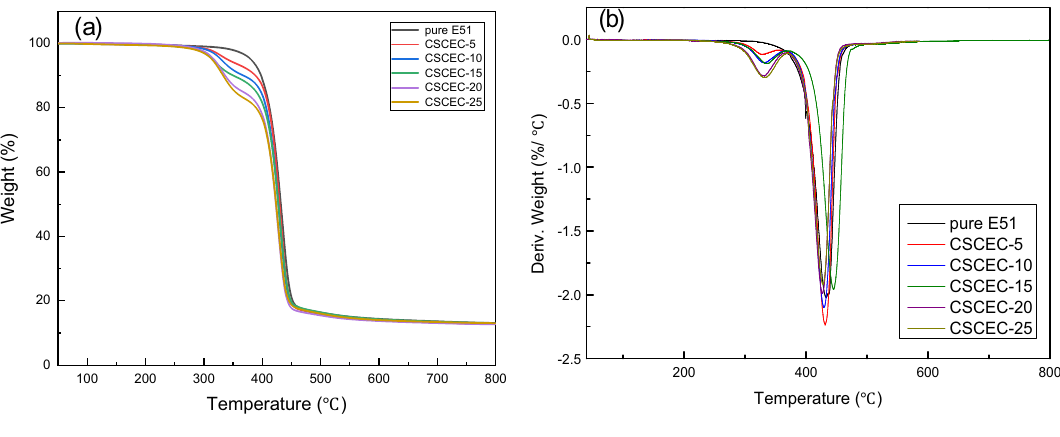
Figure 4. TG and DTG curves of pure E51 and the composites: ( a ) TG and ( b ) DTG.